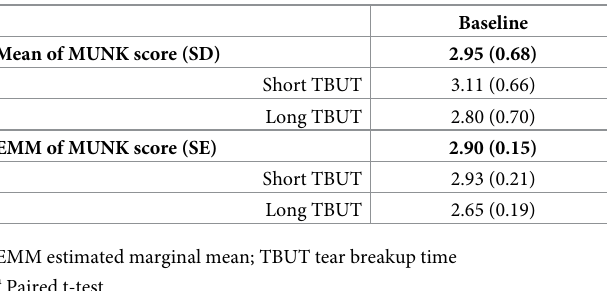
Table 3. Comparison of MUNK score at baseline and 6 months post blepharoplasty.